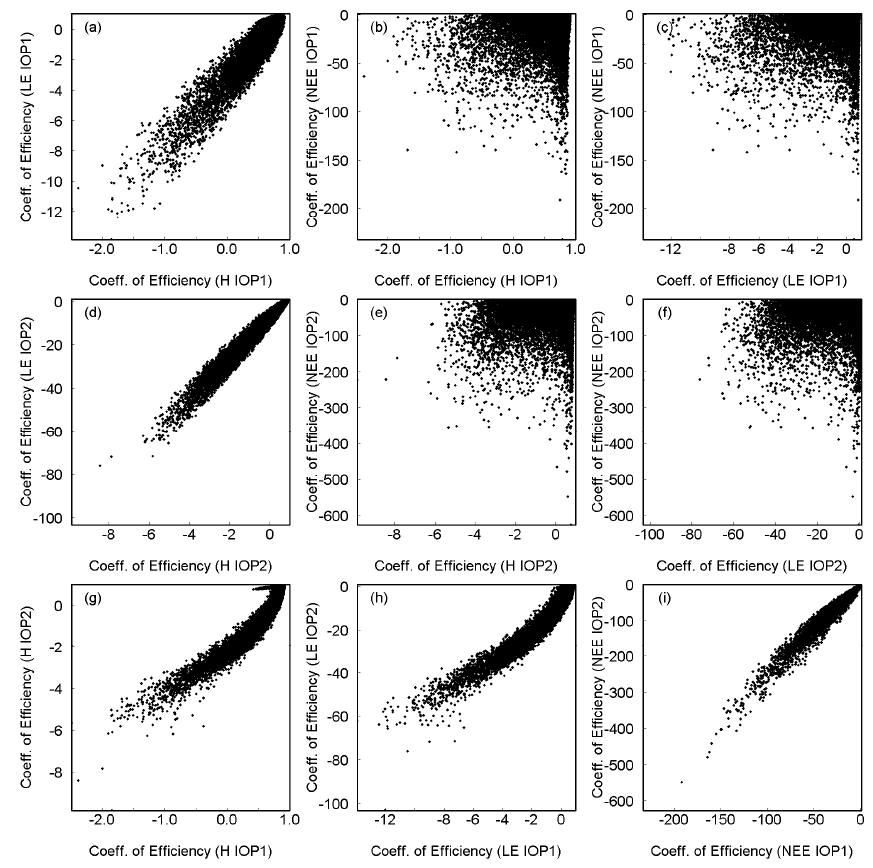
Fig. 4. Scatter plots of the coefficients of efficiency for the three fluxes. Each dot represents one parameter set. (a)–(c) : Individual coefficients of efficiency for IOP-1 compared to each other. (d)–(f) : Same as (a)–(c) but for IOP-2. (g)–(i) : For each flux, coefficients of efficiency compared for the two IOPs. Note the differences in the axis ranges.